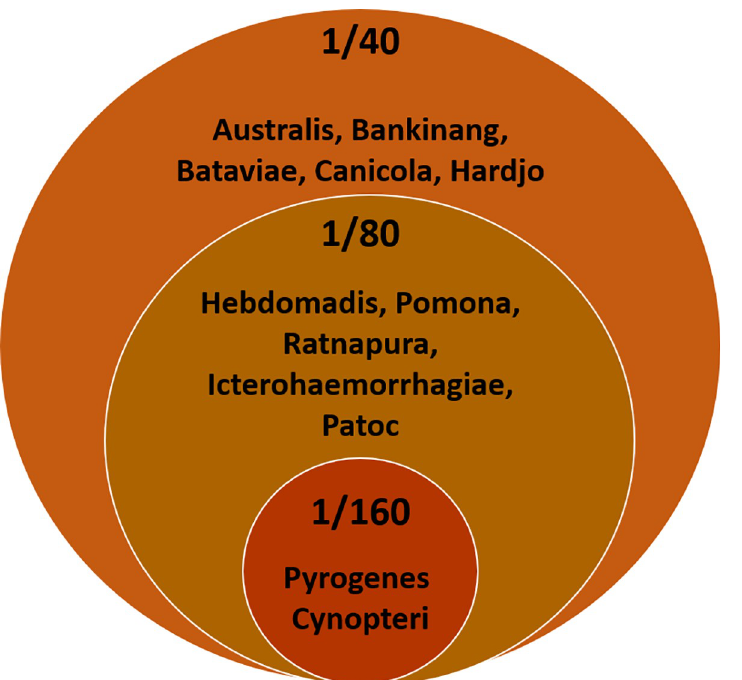
Fig 2. Suggested diagnostic cut-off titres for different